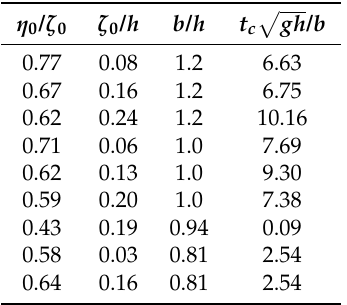
Table 2. Inclined uplift-only (IU) non-dimensional